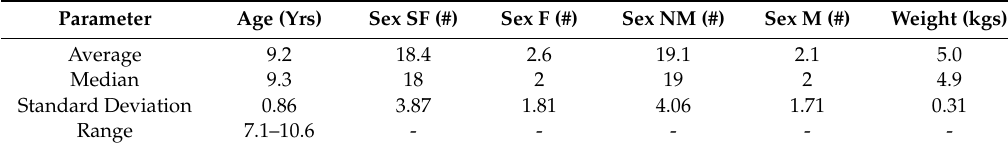
Table 2. Summary of 1000 feline cases by age, sex and